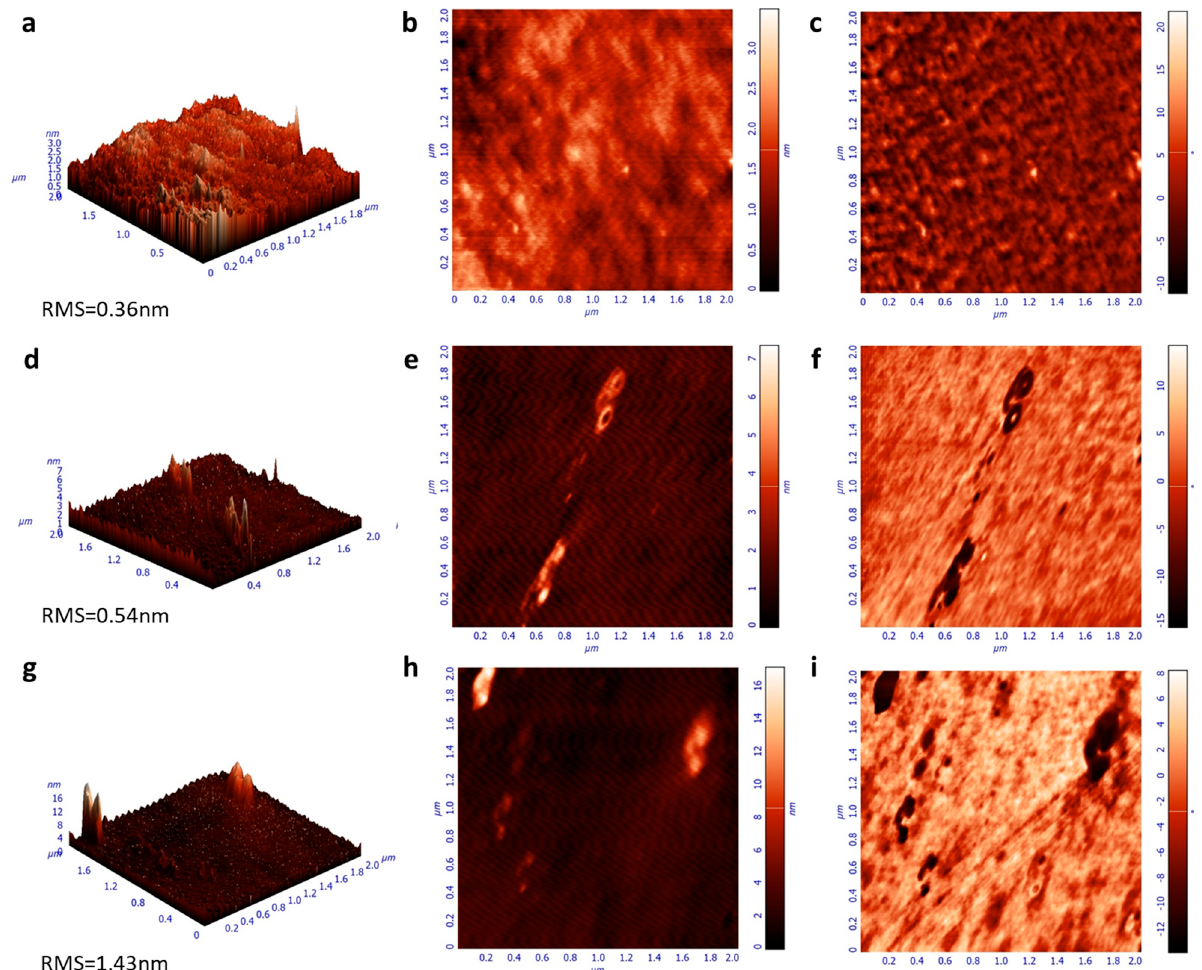
Figure 5. Atomic force microscopy (AFM) surface topographies (height, 3D-left and 2D-middle, phase-right) of ( a–c ) F8BT, ( d–f ) F8BT/C-dot and ( g–i ) F8BT/NC-dot films.